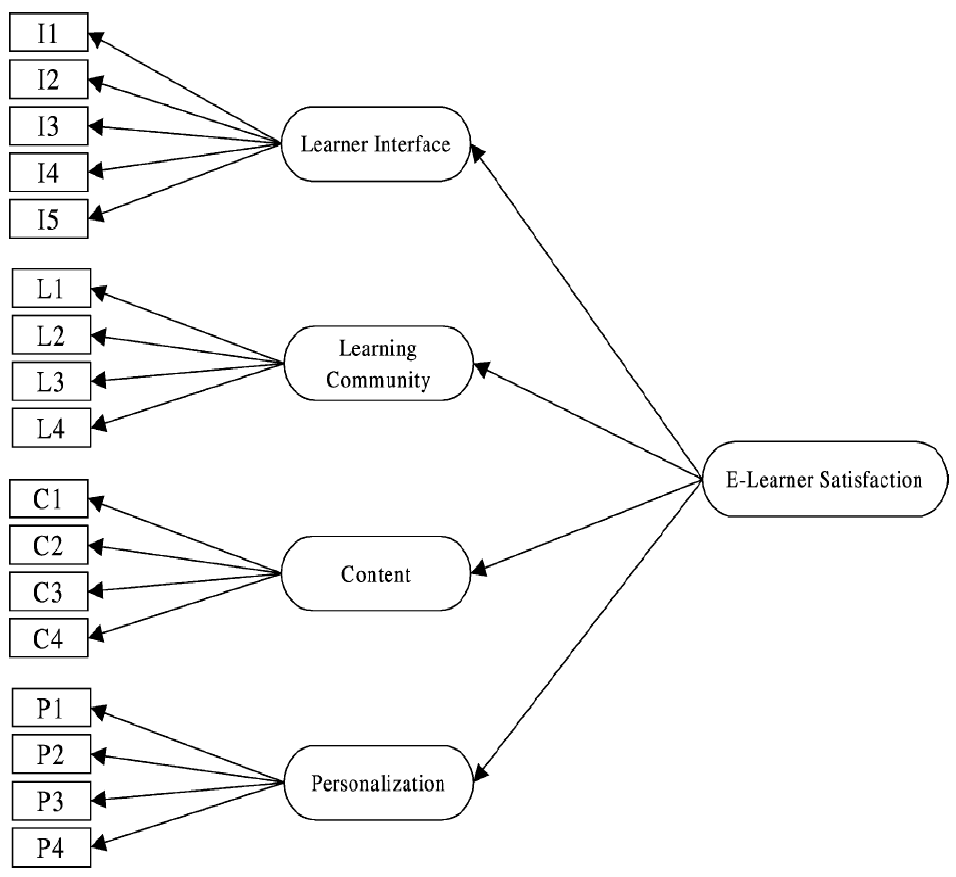
Figure A1. Wang’s (2003) proposed measurement model of the LSQ.